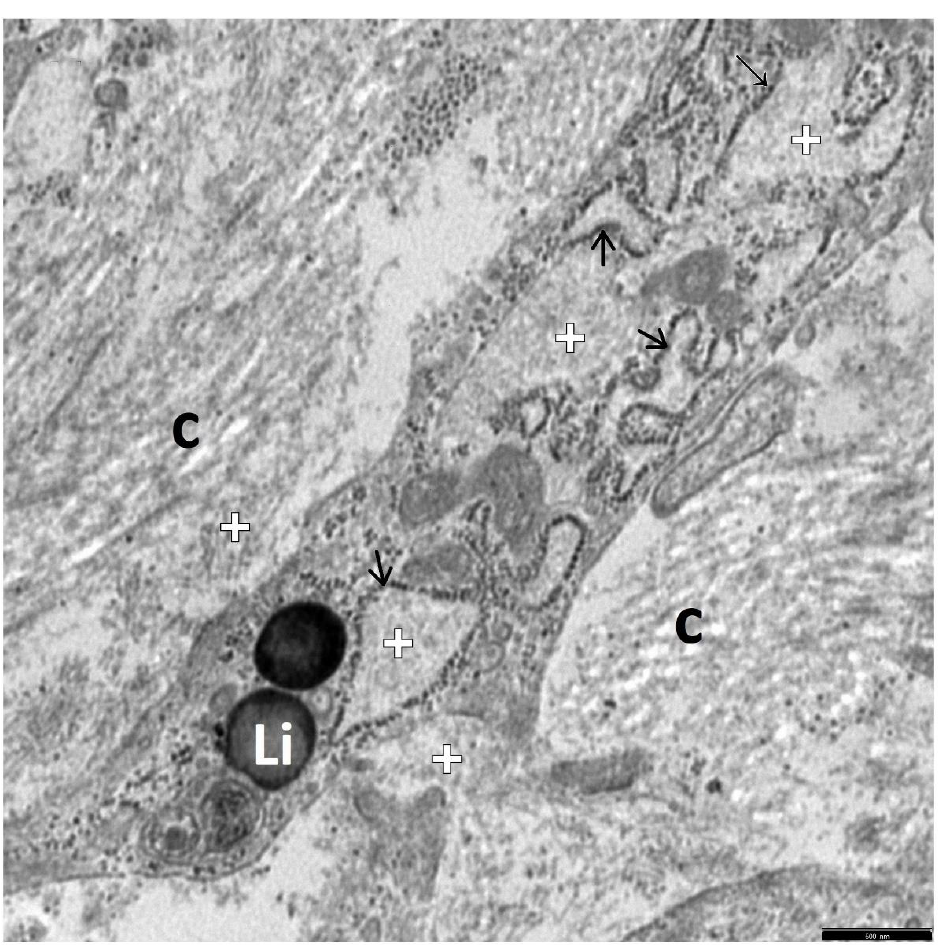
Figure 6. An electronogram of a fragment of a pHSC situated between thick bundles of mature collagen fibers (c). Its cytoplasm shows markedly dilated ger channels (->); visible areas of accumulating microfibrillar, flocculent material within substantially dilated ger channels, loosely laying outside them, and in some places, directly adhering to pHSC (+), which may correspond to deposits of immature collagen components; Li — fine single lipid droplets. Scale bar 0.5 µ m, original magnification ×20,000.